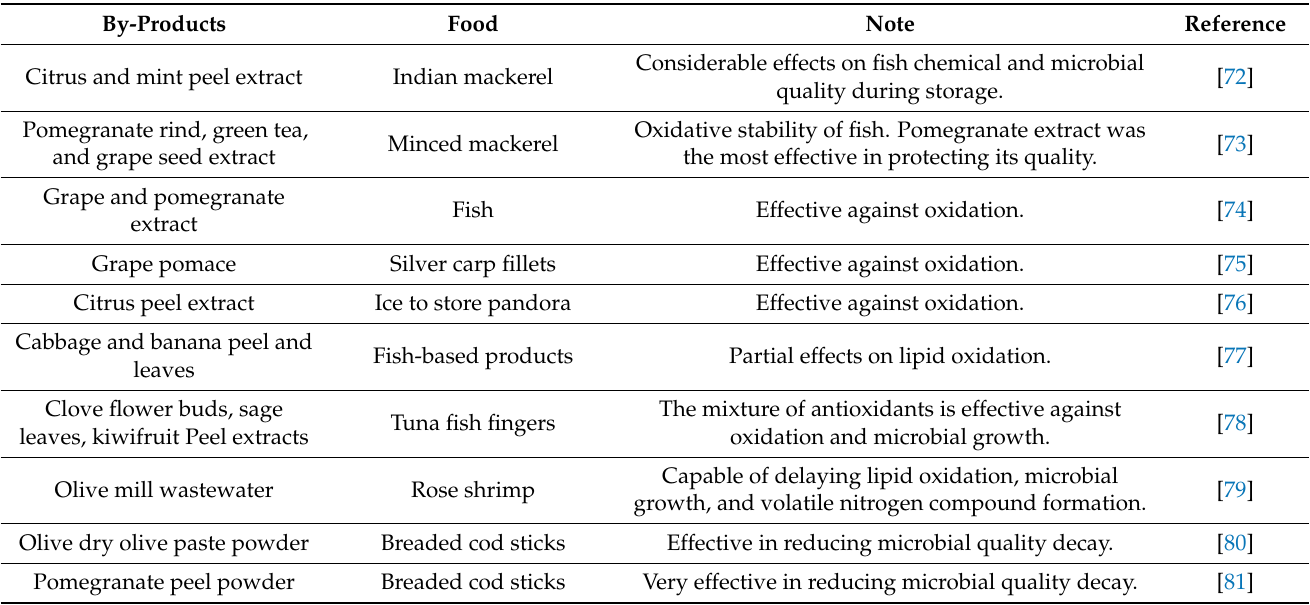
Table 5. Applications of by-products to fish